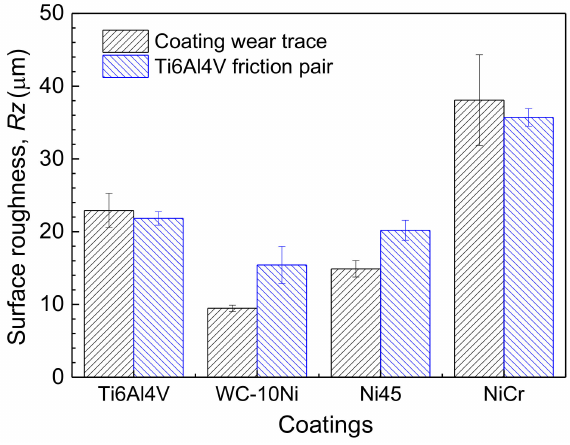
Figure 9. Wear trace roughness of the coatings and Ti6Al4V friction pair.